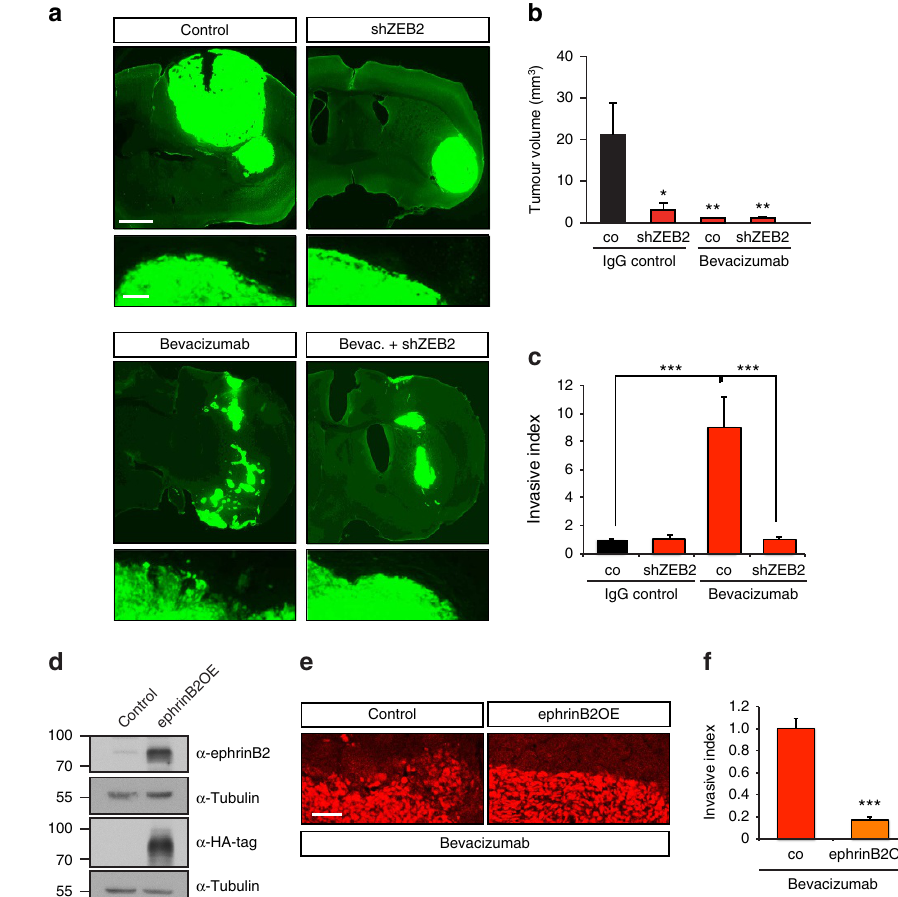
Figure 7 | ZEB2 directs glioma invasion and anti-angiogenic resistance. ( a – c ) ZEB2 silencing impairs tumour growth and blocks invasion induced by anti-angiogenic treatment. Immunofluorescence analysis of intracranial tumour xenografts of GFP-expressing polyclonal G55 pools stably transduced with scrambled control or ZEB2 shRNA following IgG control or bevacizumab treatment, together with representative pictures of tumour rims (higher magnification) ( a ). Stereological quantifications of tumour volume ( n ¼ 8 tumours) ( b ). Quantification of the invasive index assessed by measuring